Question: Generate an informative caption for the figure above.
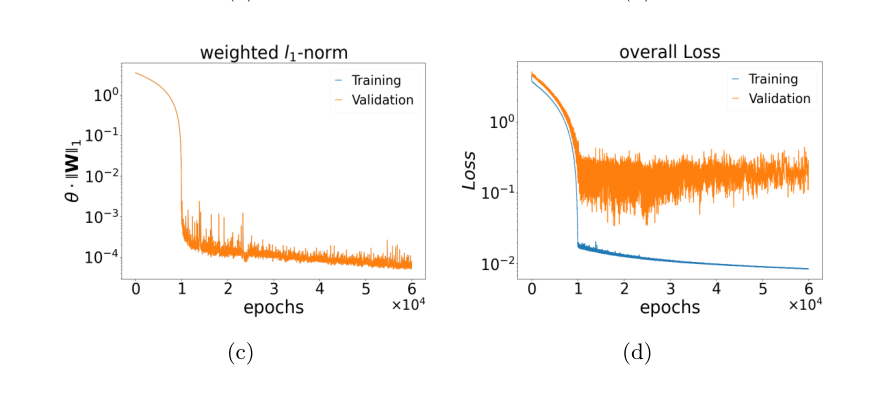
Answer: Weighted components of overall losses for infected mice versus never infected mice across domain experiment: (a) reconstruction error, (b) classification error, (c) sparsity loss, (d) total loss.